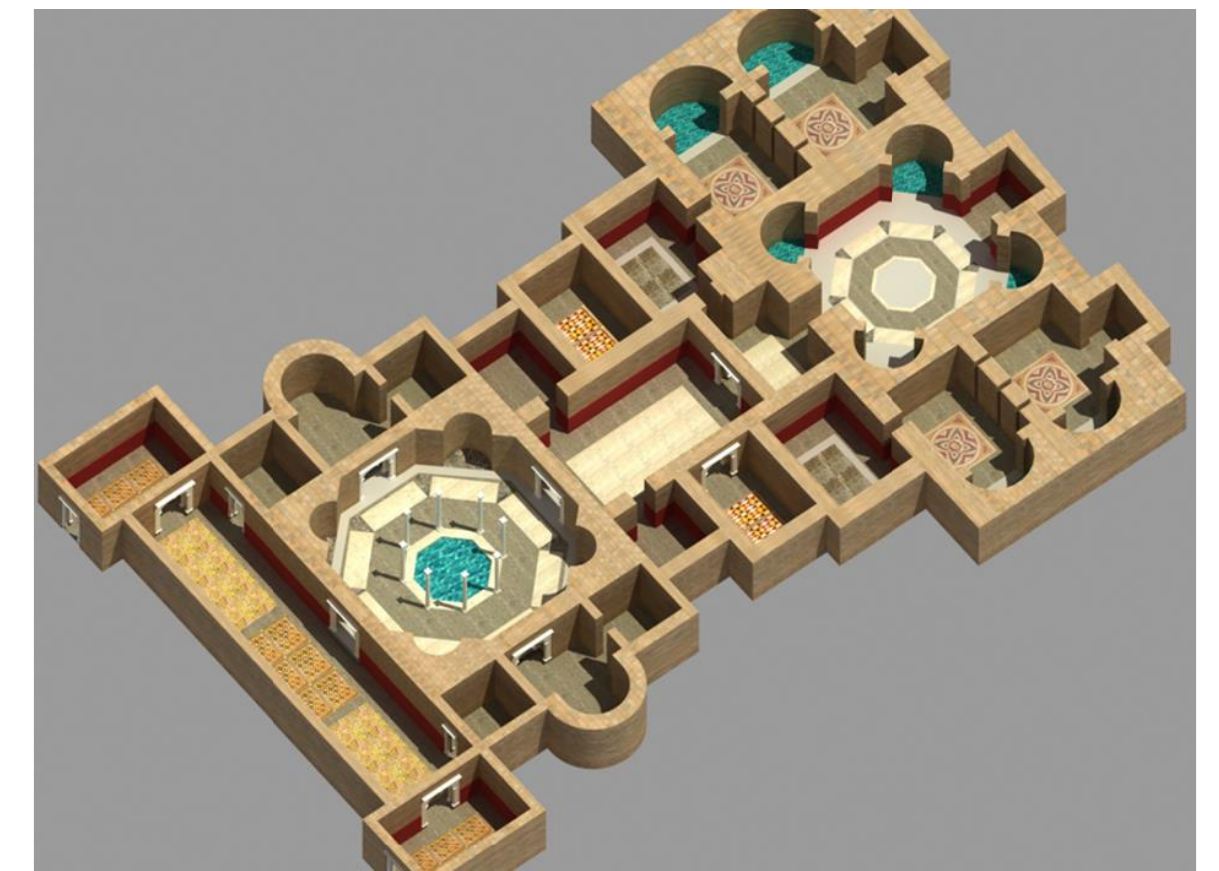
Figure 11. Model of Roman bath C, Ancient Antioch.